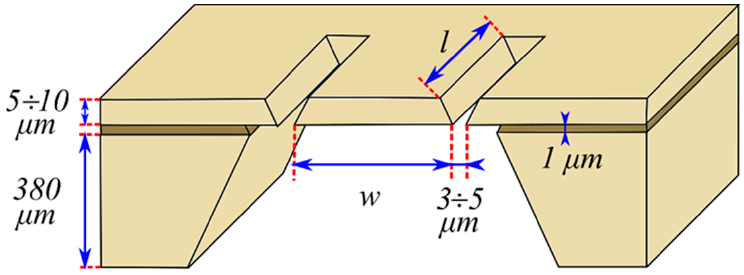
Figure 13. Silicon cantilever sensor. Typical dimensions for width w and length l are a few millime- Figure 13. Siliconcantileversensor. Typicaldimensionsforwidth w andlength l ters [116].